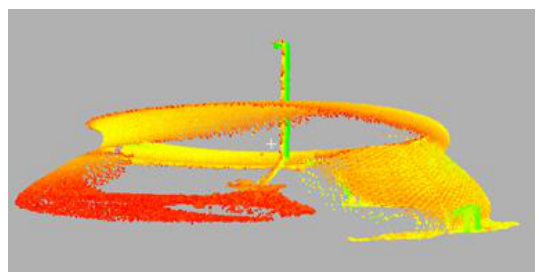
Figure 14. 3 D laser scan before refraction correction for Trial 3 [35,36] (used with permission).